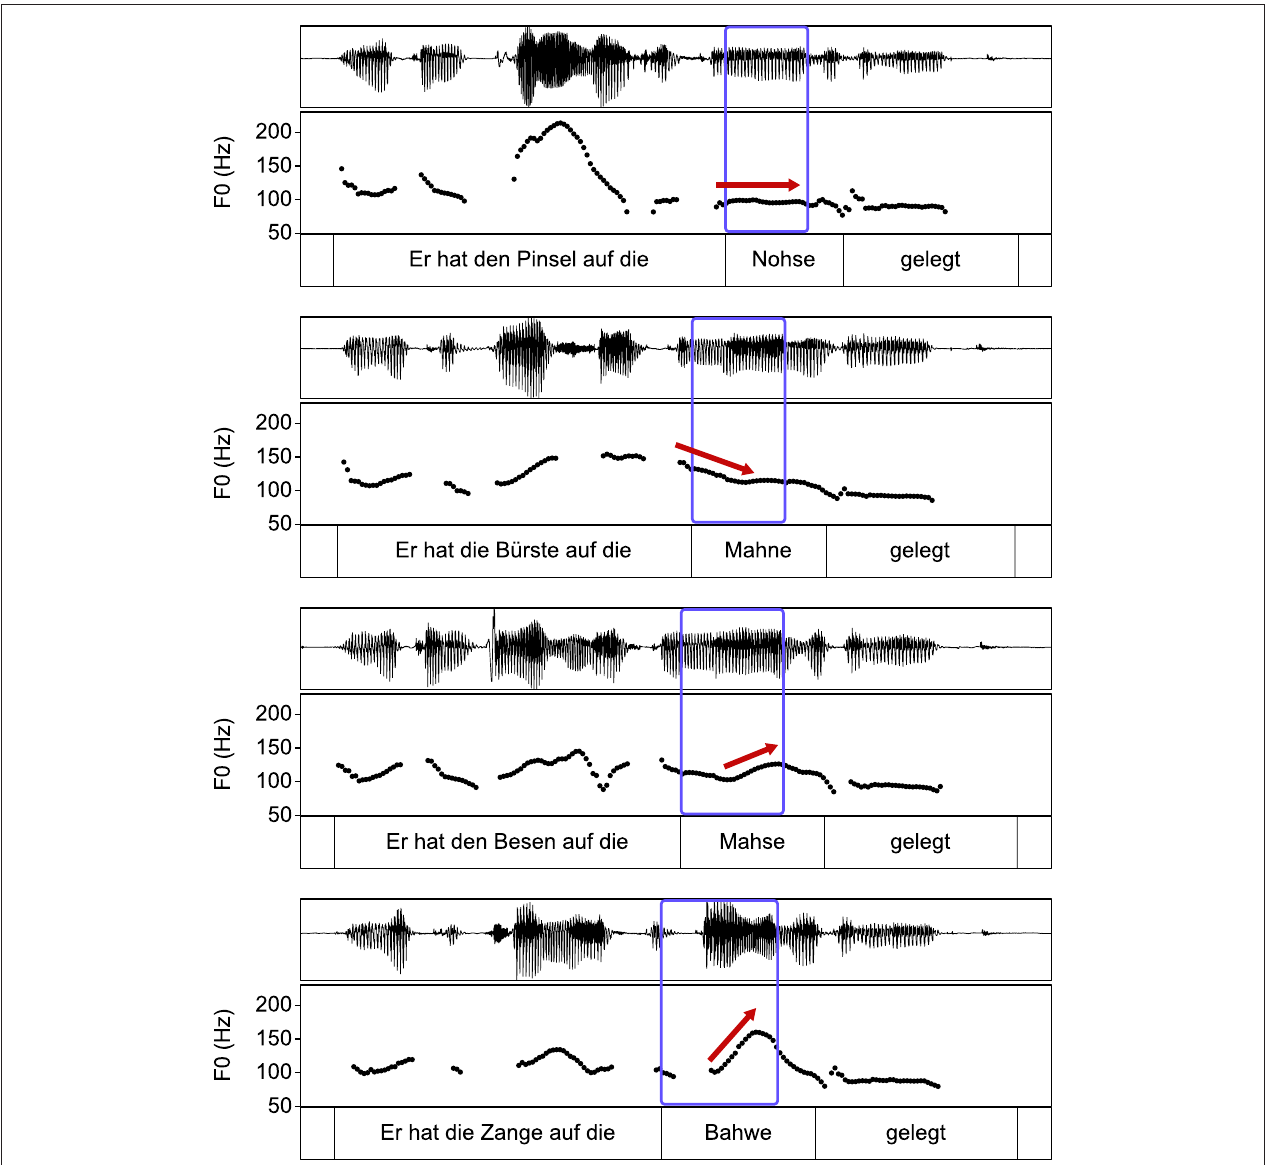
FIGURE 2 | Examples from one male speaker producing background, broad focus, narrow focus, and contrastive focus (from top to bottom). The stressed syllable of the target word is marked by the blue box. [The sentences are of the form “He placed the < tool > on the < target > ,” literally: “He has the < tool > on the < target > placed,” see the methods section for more information on the speech